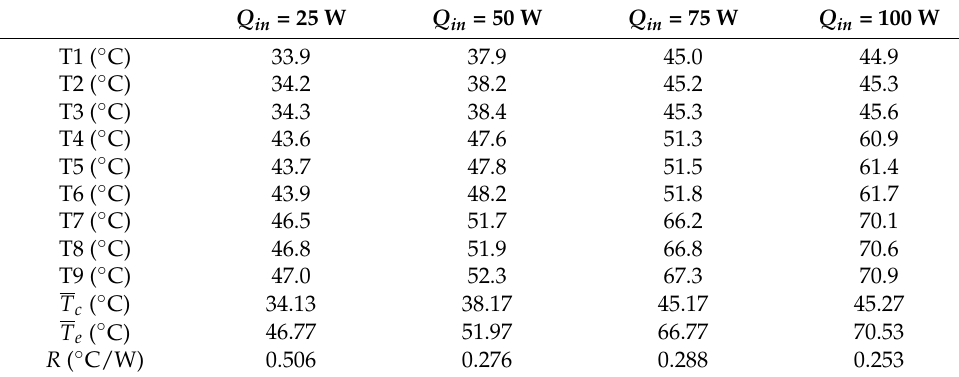
Table 2. Experimental data of the heat pipe after anodic oxidation treatment (50 V and 9